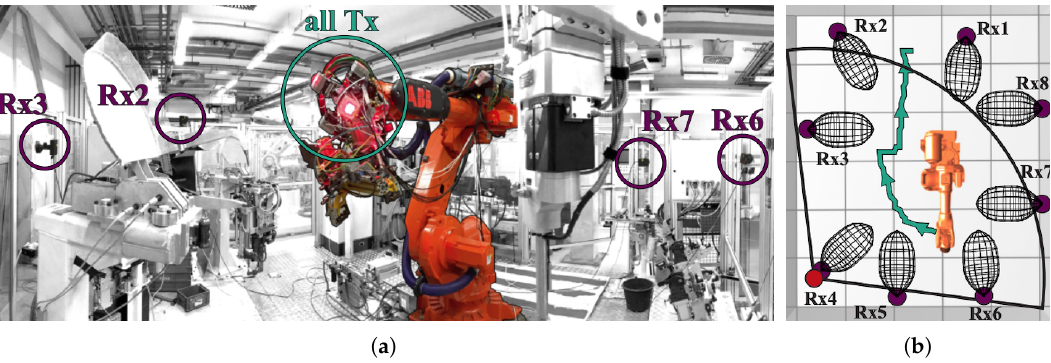
Figure 8. ( a ) The manufacturing cell used for the experiments at BMW’s robot testing facility; and ( b ) the robot arm movement trace investigated in [13]. The figures were adopted from